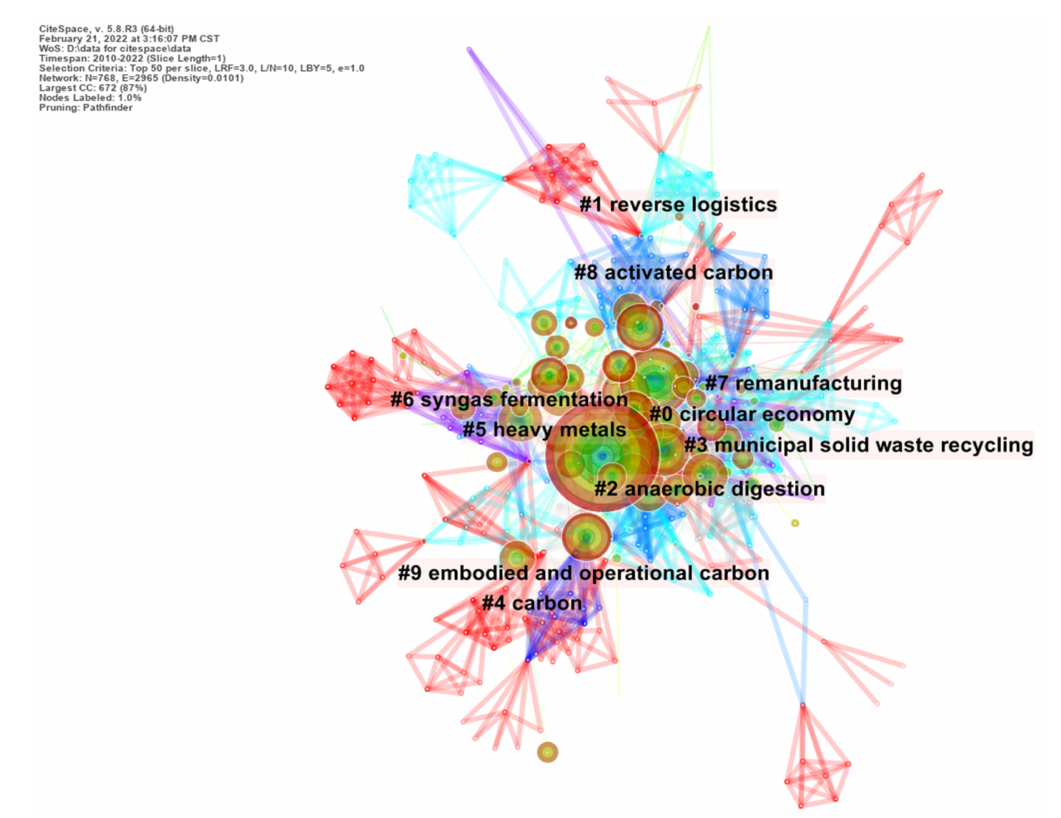
Figure 9. Keyword clusters of cited articles. Figure 9 controls the number of displayed nodes according to the keyword frequency.